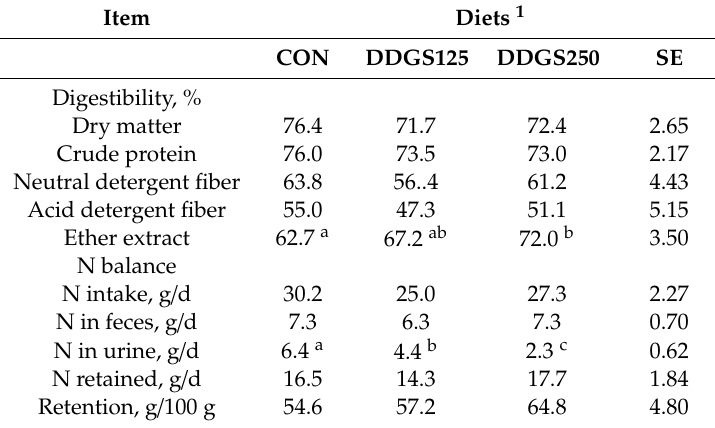
Table 3. E ff ects of feeding dried distillers’ grains with solubles (DDGS) on nutrient digestibility, N balance and rumen fluid pH of growing Awassi